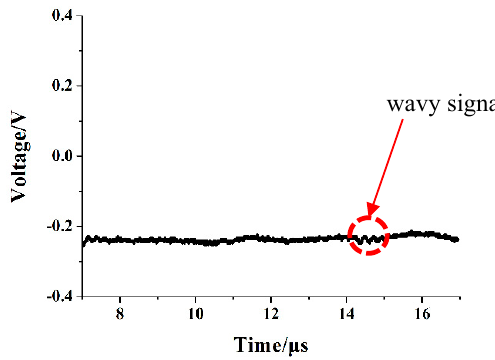
Figure 5. Discharge waveform with the N 2 flow velocity of 1 L / min.